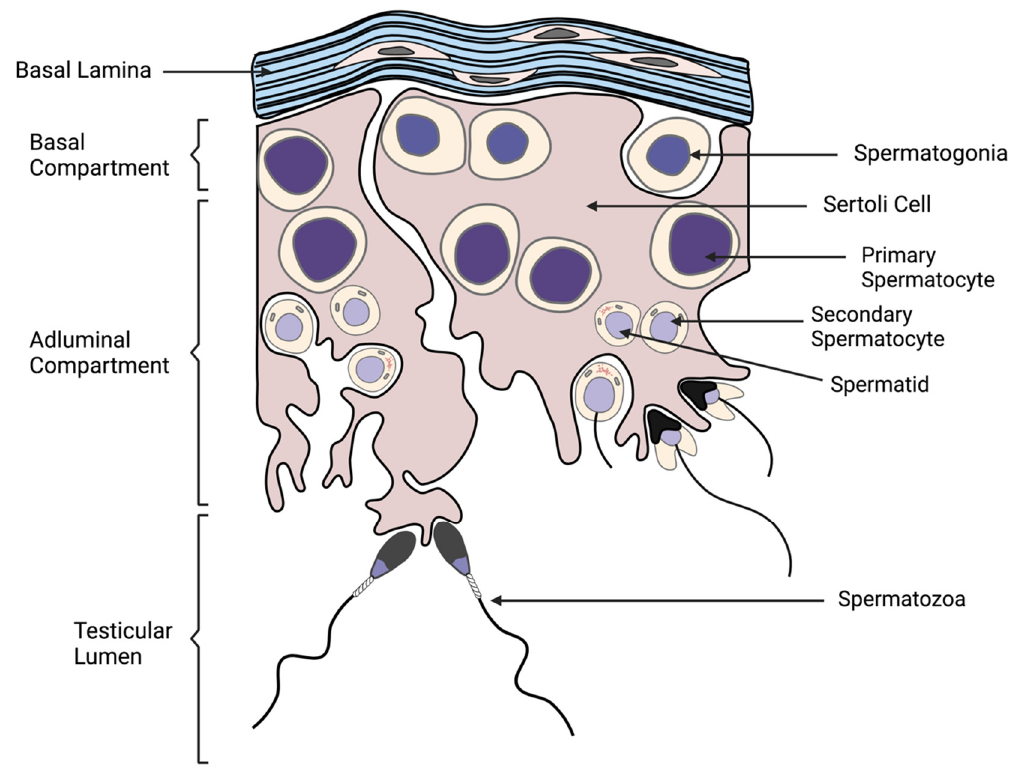
Figure 1. Schematic presentation of spermatogenesis. Facilitated by the nurturing Sertoli cells, basal spermatogonia replicate and differentiate into primary spermatocytes, and sequentially develop into secondary spermatocytes, spermatids, and the morphologically distinct spermatozoa during spermatogenesis. Spermatozoa are released into the lumen of the seminiferous tubule of the testis during spermiation.